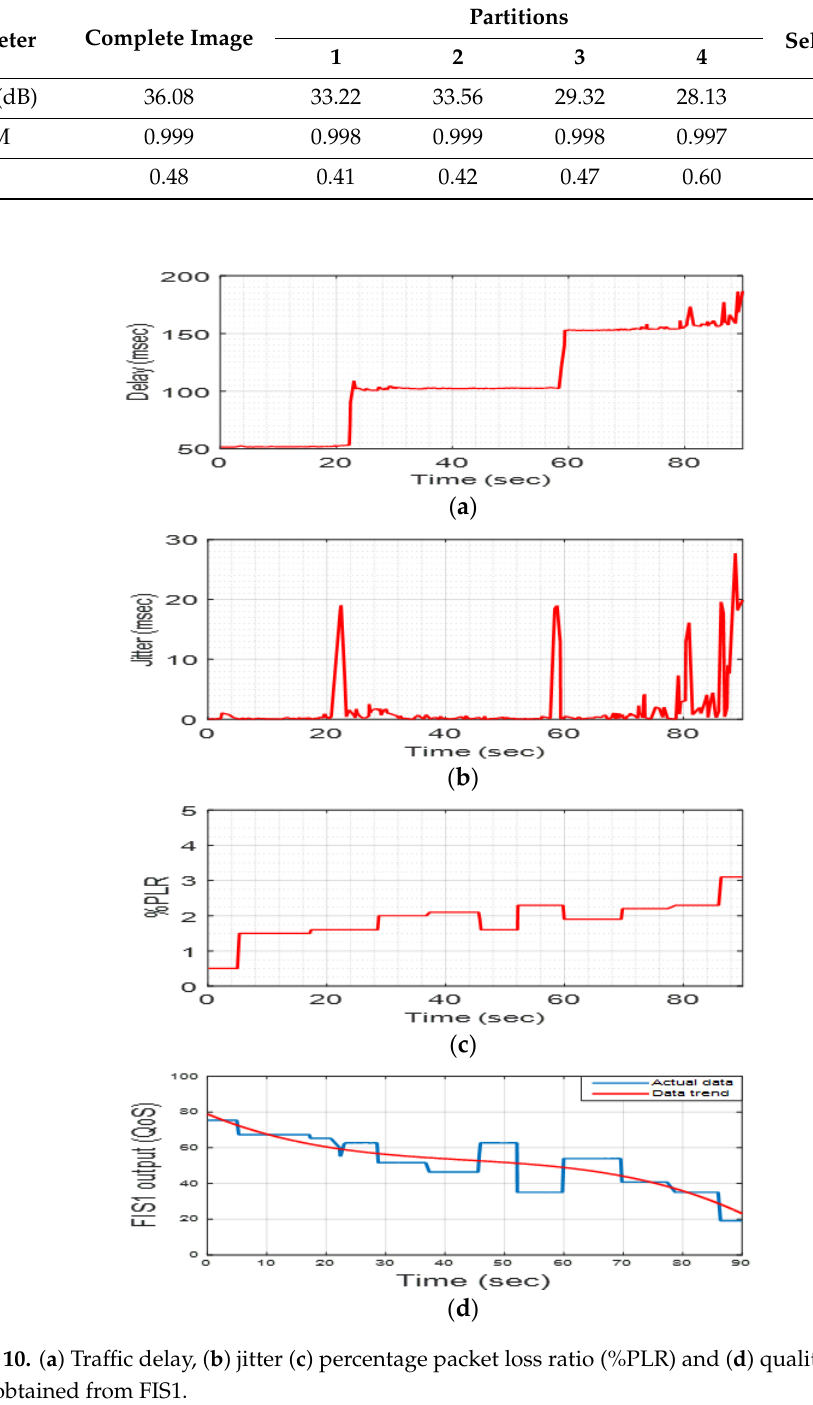
( b ) Figure 11. PSNR (in dB): ( a ) Full image and ( b ) partitioned image.